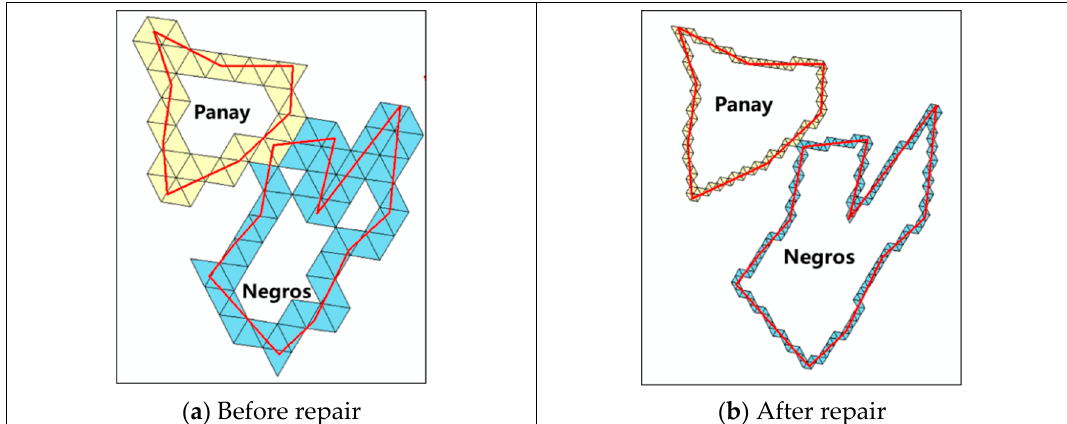
Figure 15. An example of topology distortion repair of line features by gridding.